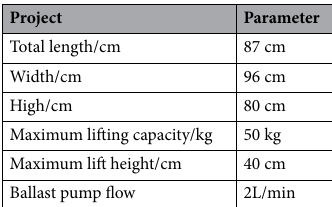
Table 1. Model robot parameters.